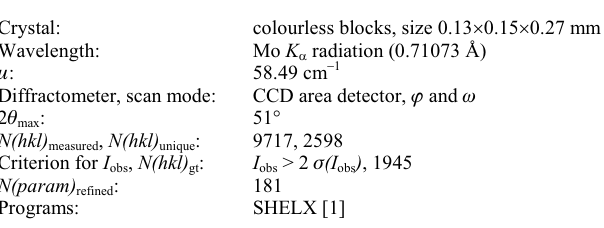
Table 1. Data collection and handling.